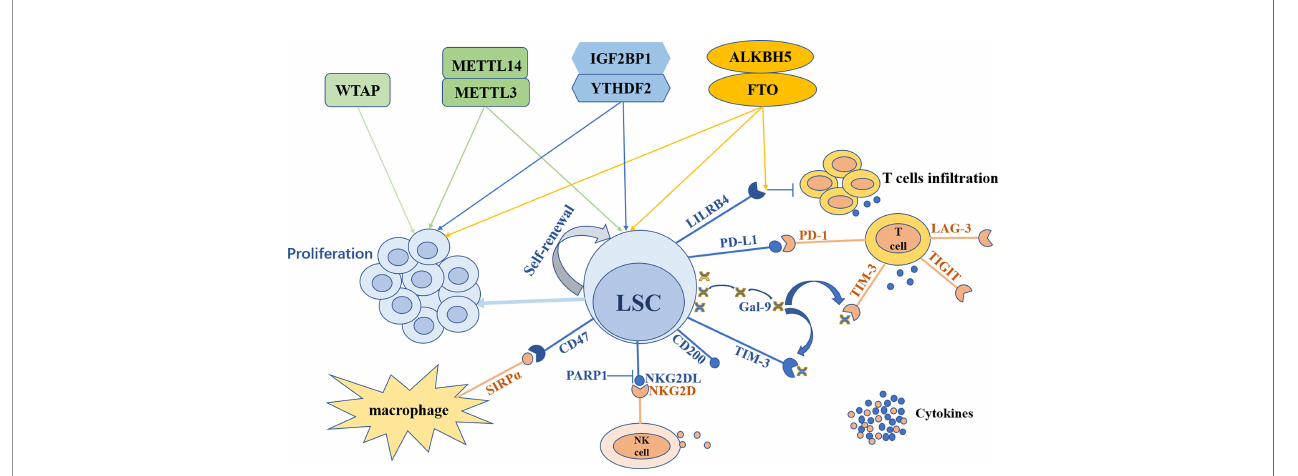
FIGURE 2 | The outline of m 6 A modi fi cation in leukemia stem cells and the tumor immune microenvironment. Leukemia stem cells (LSCs) can maintain self-renewal and trigger leukemia cells proliferation. LSCs can escape from the surveillance and elimination of the immune system through various mechanisms. With the expression of TIM-3, LSCs secrete galectin-9 (Gal-9) to form TIM-3/Gal-9 autocrine loop. Meanwhile Gal-9 combines with TIM-3 expressed on T cells to inhibit T cells immunity. Furthermore, LSCs express PD-L1 to recognize and bind its receptor PD-1 on T cells to impede the killing of T cells. LSCs can also express LILRB4 and CD200 to suppress T cells activity. In addition, LSCs can express CD47 to combine with SIRP a on macrophages to escape from innate immune attacks and can suppress NKG2DL expression through PARP1 to avoid NK cells killing. m 6 A modi fi cation both participates in the regulation of LSCs and the TIME. METTL3, METTL14, FTO, ALKBH5, YTHDF2 and IGF2BP1 can both promote LSCs self-renewal and leukemia cells proliferation, while WTAP can only enhance leukemia cells proliferation. FTO regulates the expression of LILRB4 on LSCs to suppress T cells in fi ltration and cytokines secretion in an m 6 A-dependent